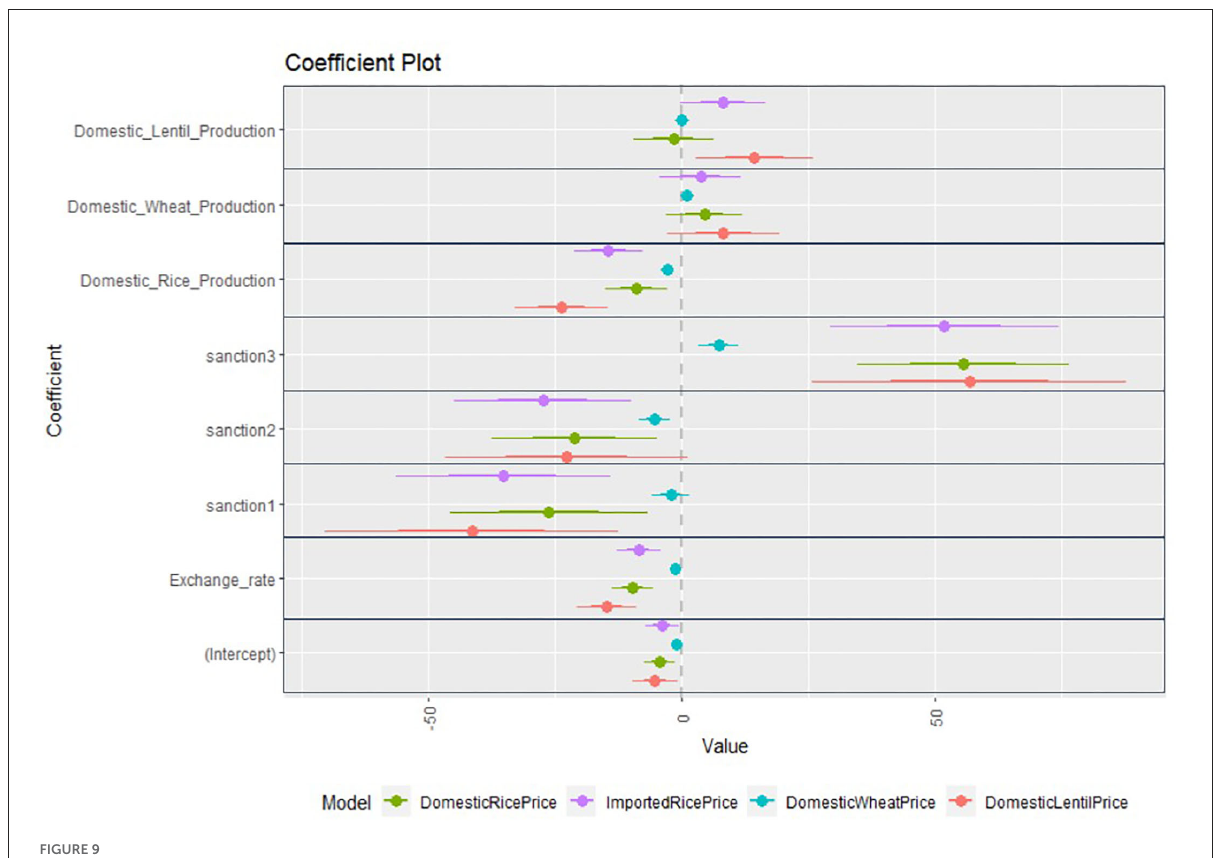
FIGURE9 Linear regression results for detrended values and based on the regression